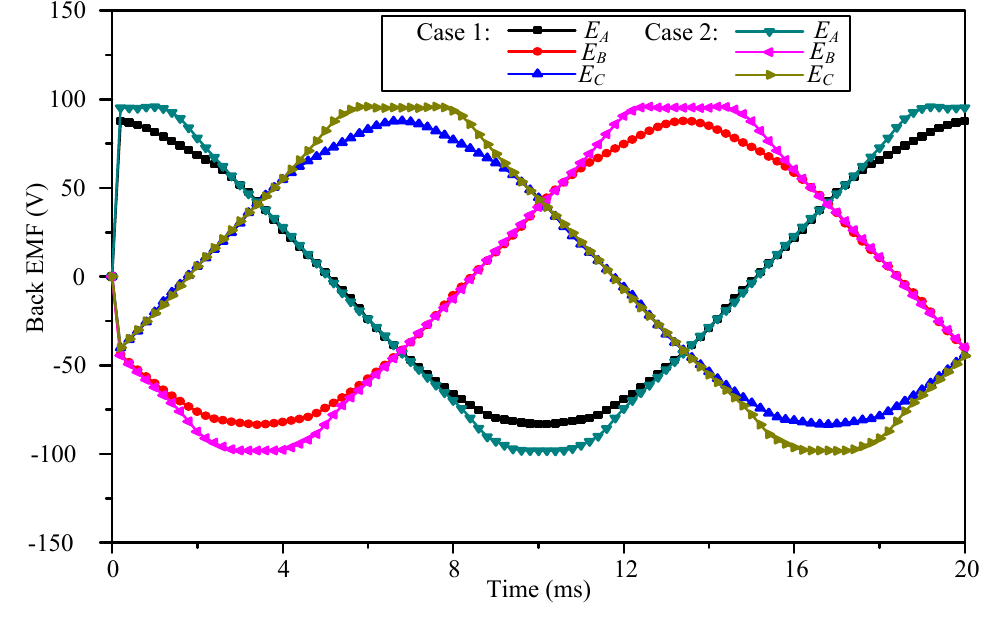
Figure 5. Comparison of back electromotive force